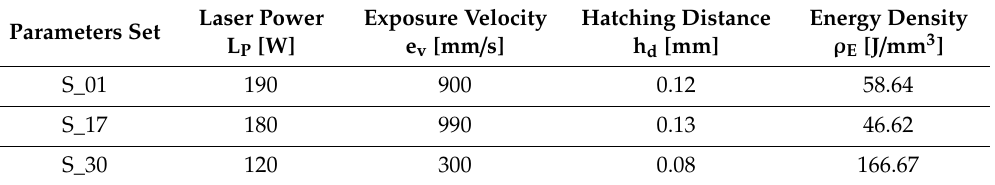
Table 3. Parameter groups used for sample